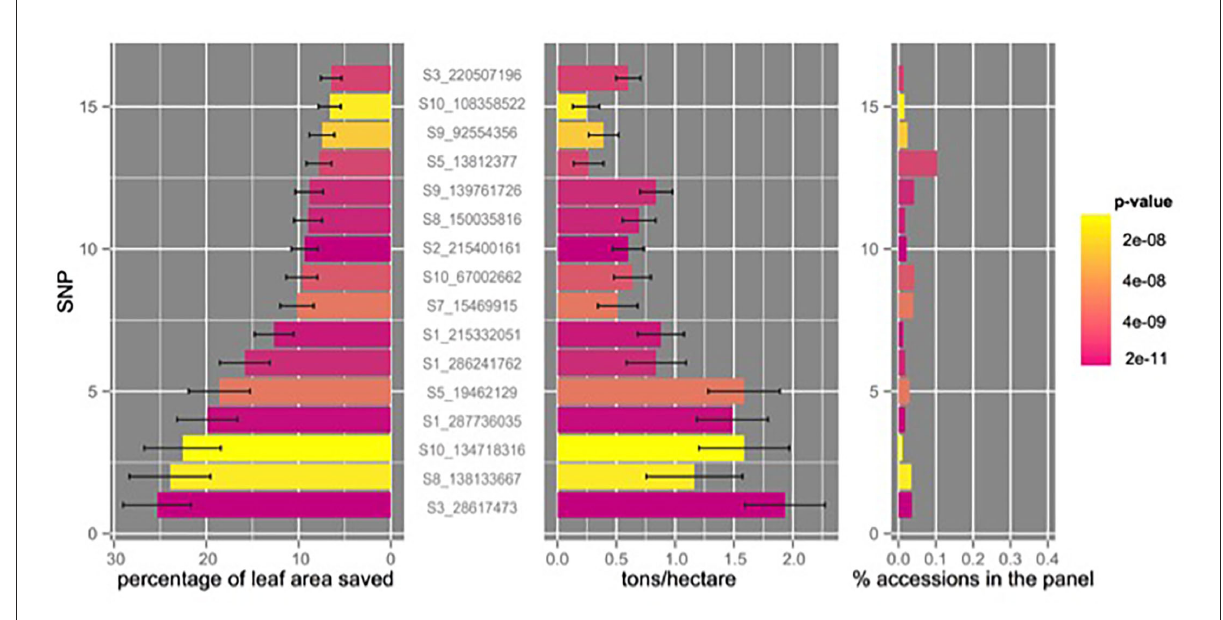
FIGURE5 Allele frequencies, association significance, allelic effect sizes for resistance, and adjusted grain yield for TSC (tar spot complex resistant SNP variants (mean ± std err). TSC resistance was translated into percentage of leaf area saved; the grain yield was shown in